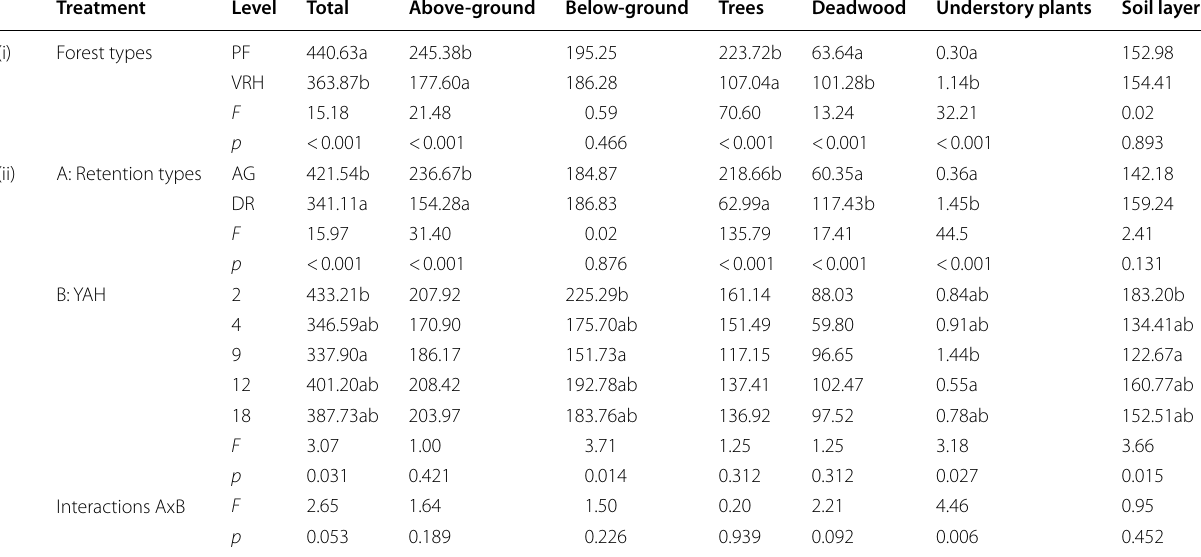
Table 3 Comparisons for carbon content (t C ha − 1 ) of total, biomass allocations and categories of forest reservoirs (see Table 1): (i) simple ANOVAs considering primary unmanaged forests (PF) and stands under variable retention harvesting (VRH), and (ii) multiple ANOVAs considering different retention types in harvested stands (AG: aggregated retention; DR: dispersed retention) and years after harvesting (YAH) as main factors